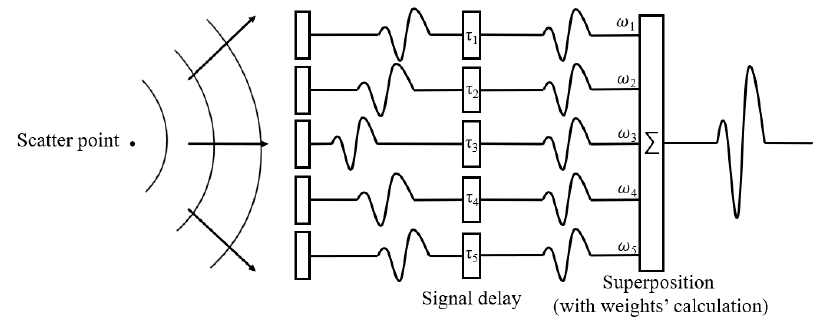
Figure 7. A beamformer illustration.